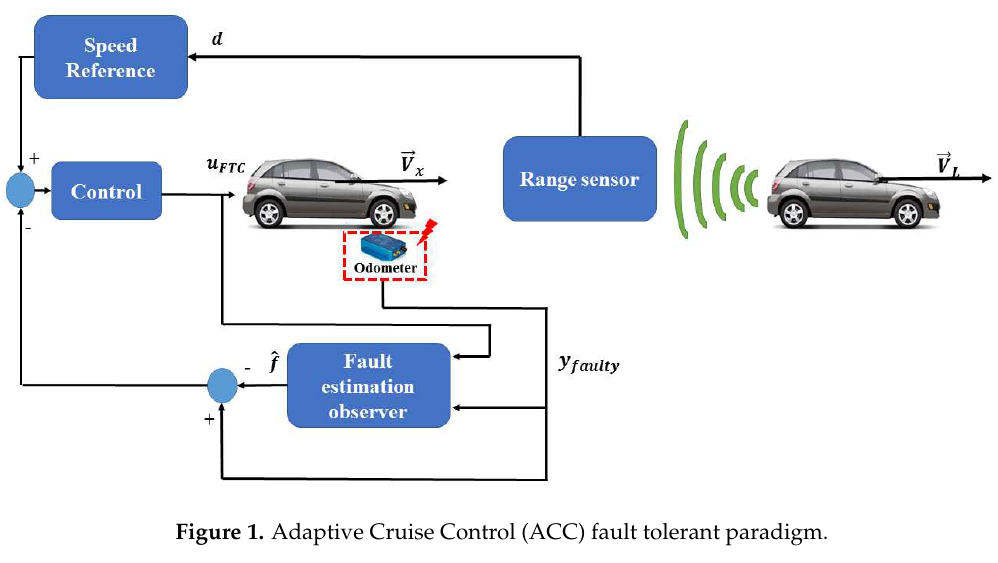
Figure 1. Adaptive Cruise Control (ACC) fault tolerant